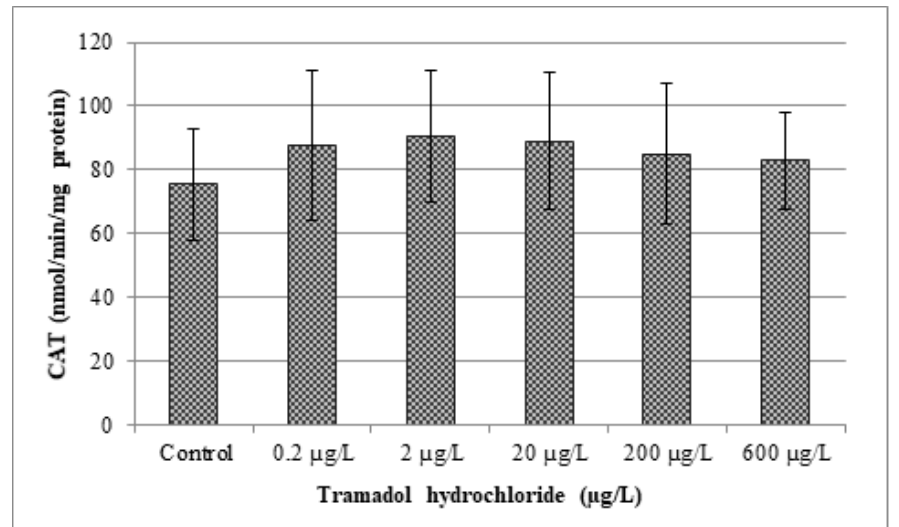
Figure 2. Analysis of catalase (CAT). Data are expressed as mean ± standard deviation. No significant differences ( p > 0.05) were found between control and experimental groups.